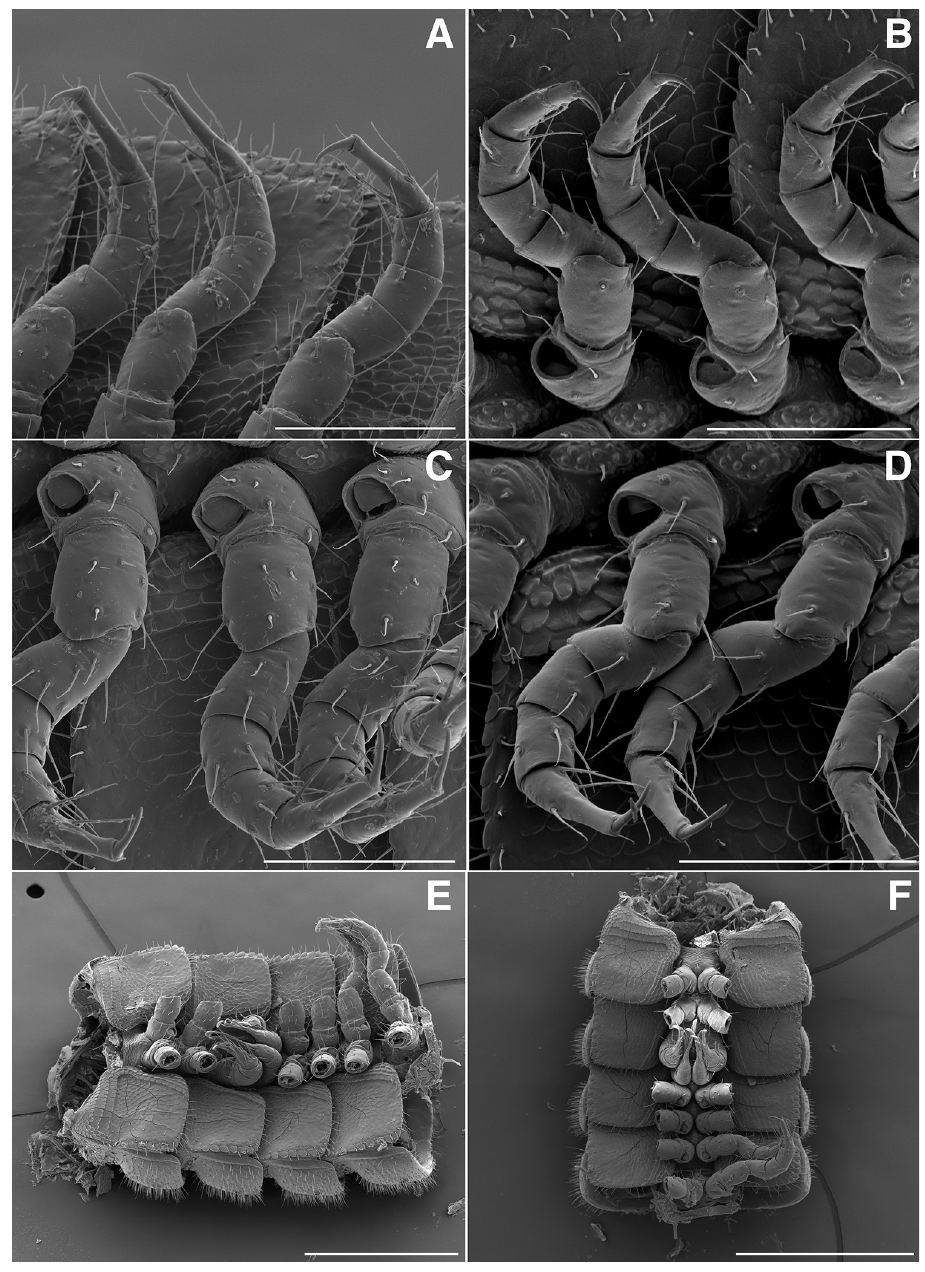
Figure 17. A Ventral view of left postgonopodal legs and claws of I. tobini sp. n. (scale bar 100 µm) B the same of I. plenipes (scale bar 100 µm). C Ventral view of left postgonopodal legs and eversible sacs of I. tobini sp. n. (scale bar 100 µm) D the same of I. plenipes (scale bar 100 µm). Illacme tobini sp. n.: A ventrolateral (right) view of rings 6–9 with gonopods in situ (scale bar 300 µm) B ventral view of the same (scale bar 400 µm). (Catalog #s: I. tobini sp. n. MPE00735, I. plenipes